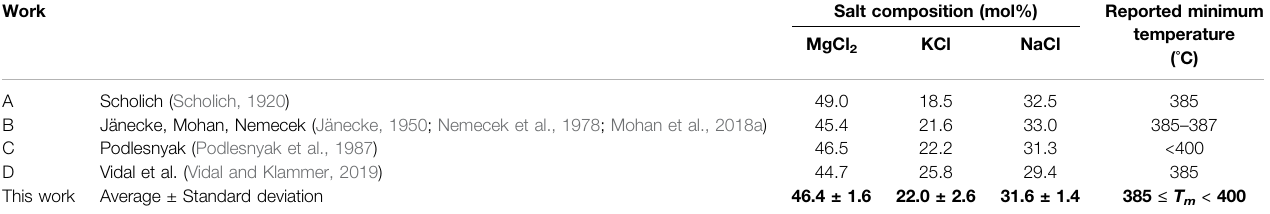
TABLE 2 | Different compositions (in mol%) and minimum melting temperature data following the literature review with phase diagram measurements.